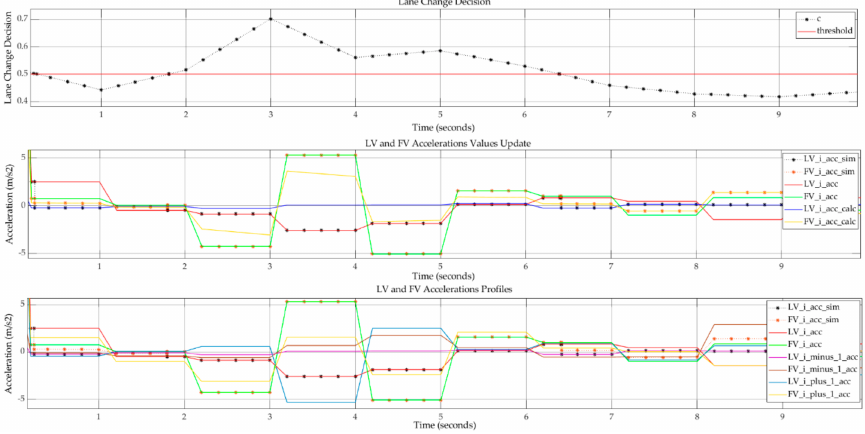
Figure 10. LV and FV from lane L i —accelerations values update.